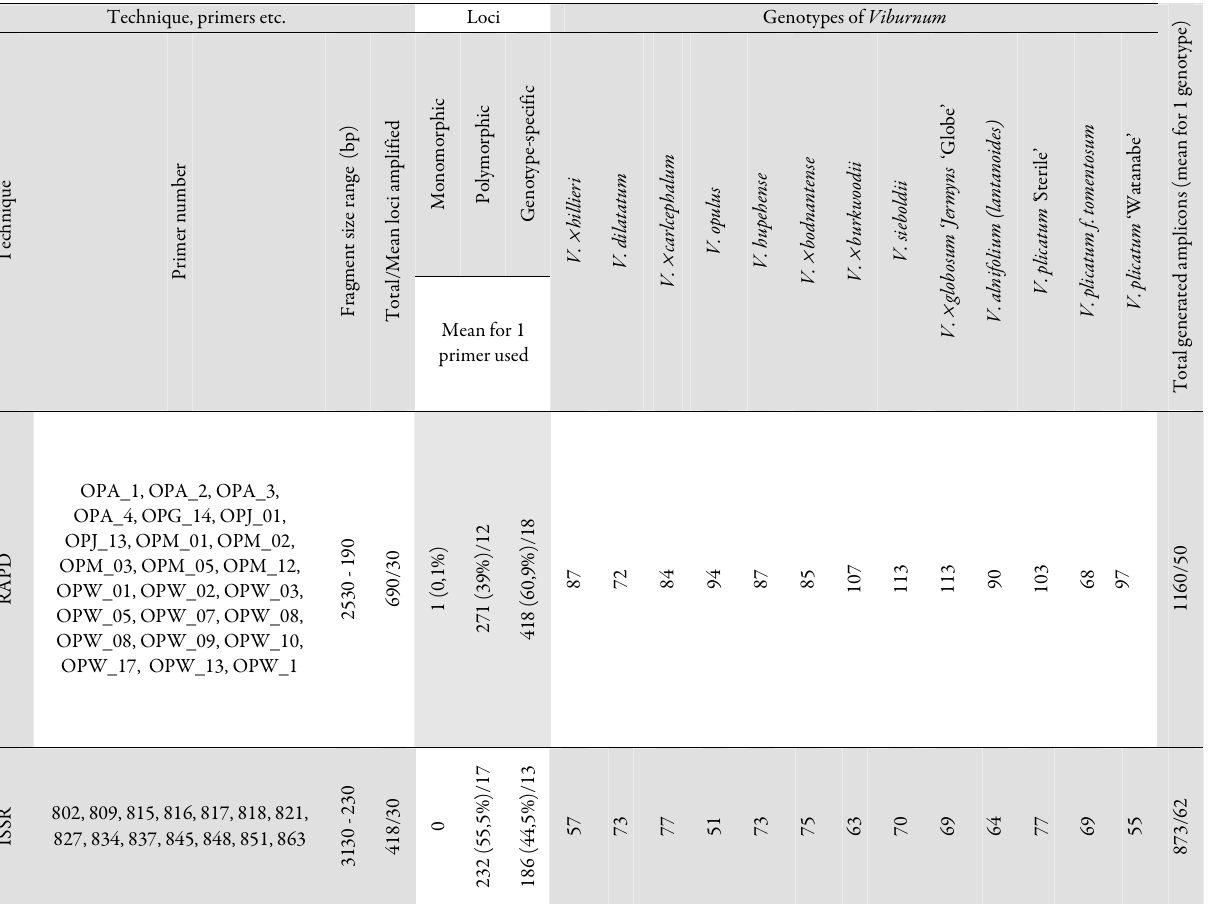
Tab. 1. Characteristic of generated RAPD and ISSR products for 13 genotypes of